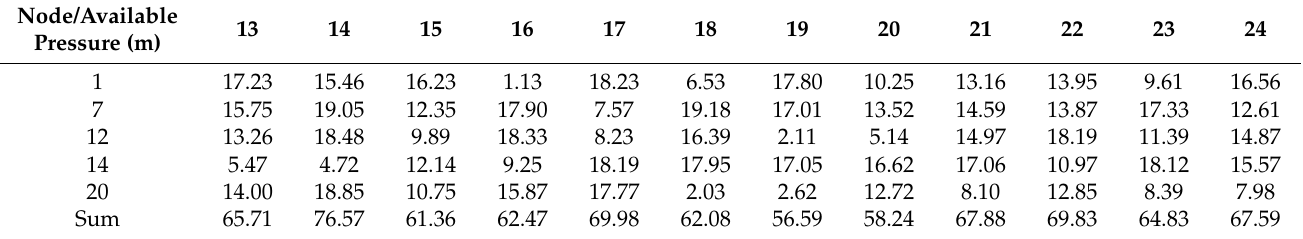
Table 5. Excessive pressure at the last 12